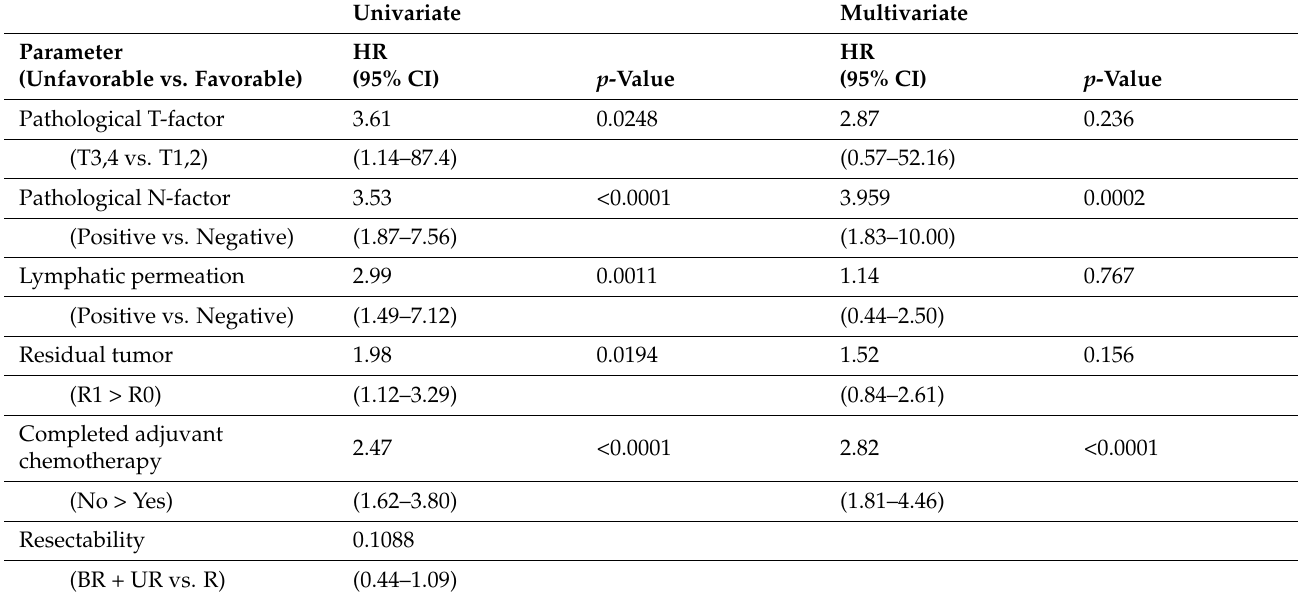
Table 1. Predictive factors for relapse in surgical